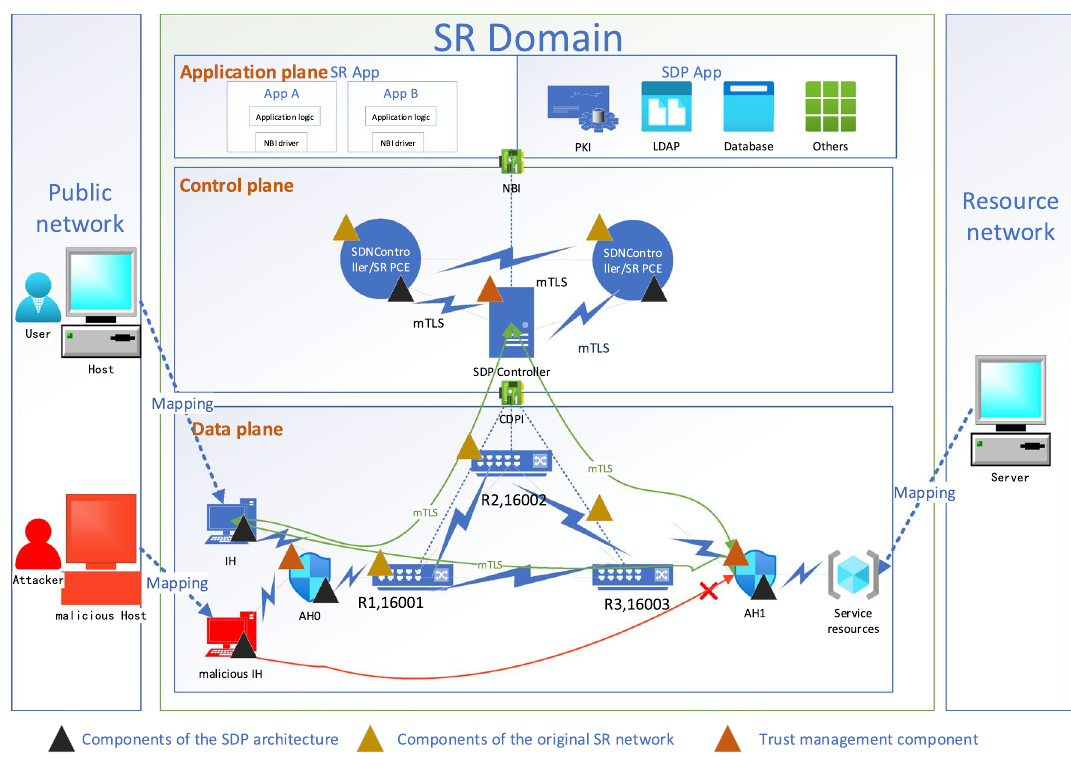
Figure 4. SbSR security model